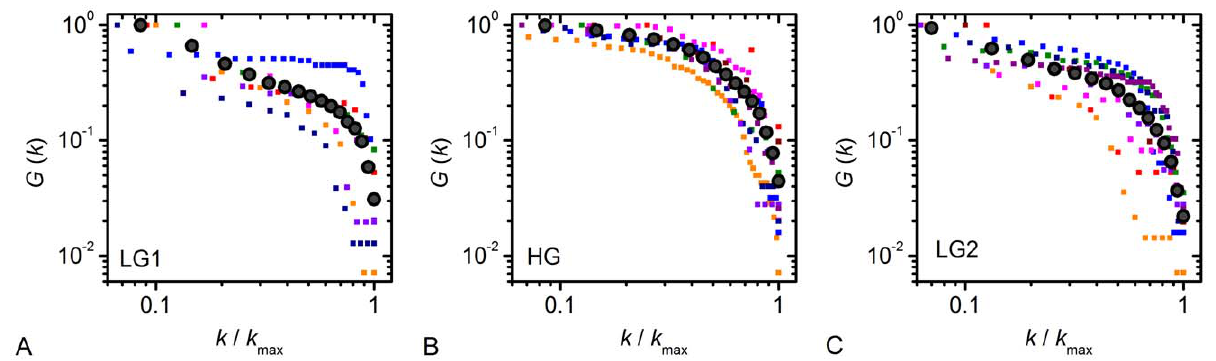
Figure 6. Cumulative degree distributions of functional networks for three of the five regimes analyzed. Values obtained from all 9 islets are plotted in different colors and the larger black circles indicate their average for low glucose prior to stimulation (A), high glucose (B), and low glucose after stimulation (C). The node degree distributions decay roughly linearly before a drop-off in the tail, thereby indicating a broad-scale nature of the networks.